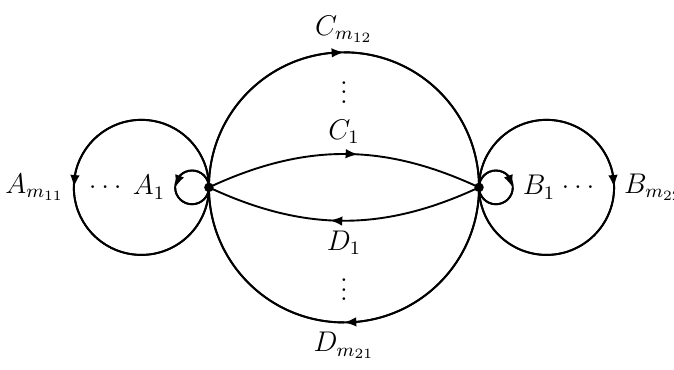
Figure 1 . This figure gives a graphical representation of the excited brane bound states described by the generating function (2.35). The node on the left represents the brane with momentum p 1 while the node on the right is for the brane of momentum p 2